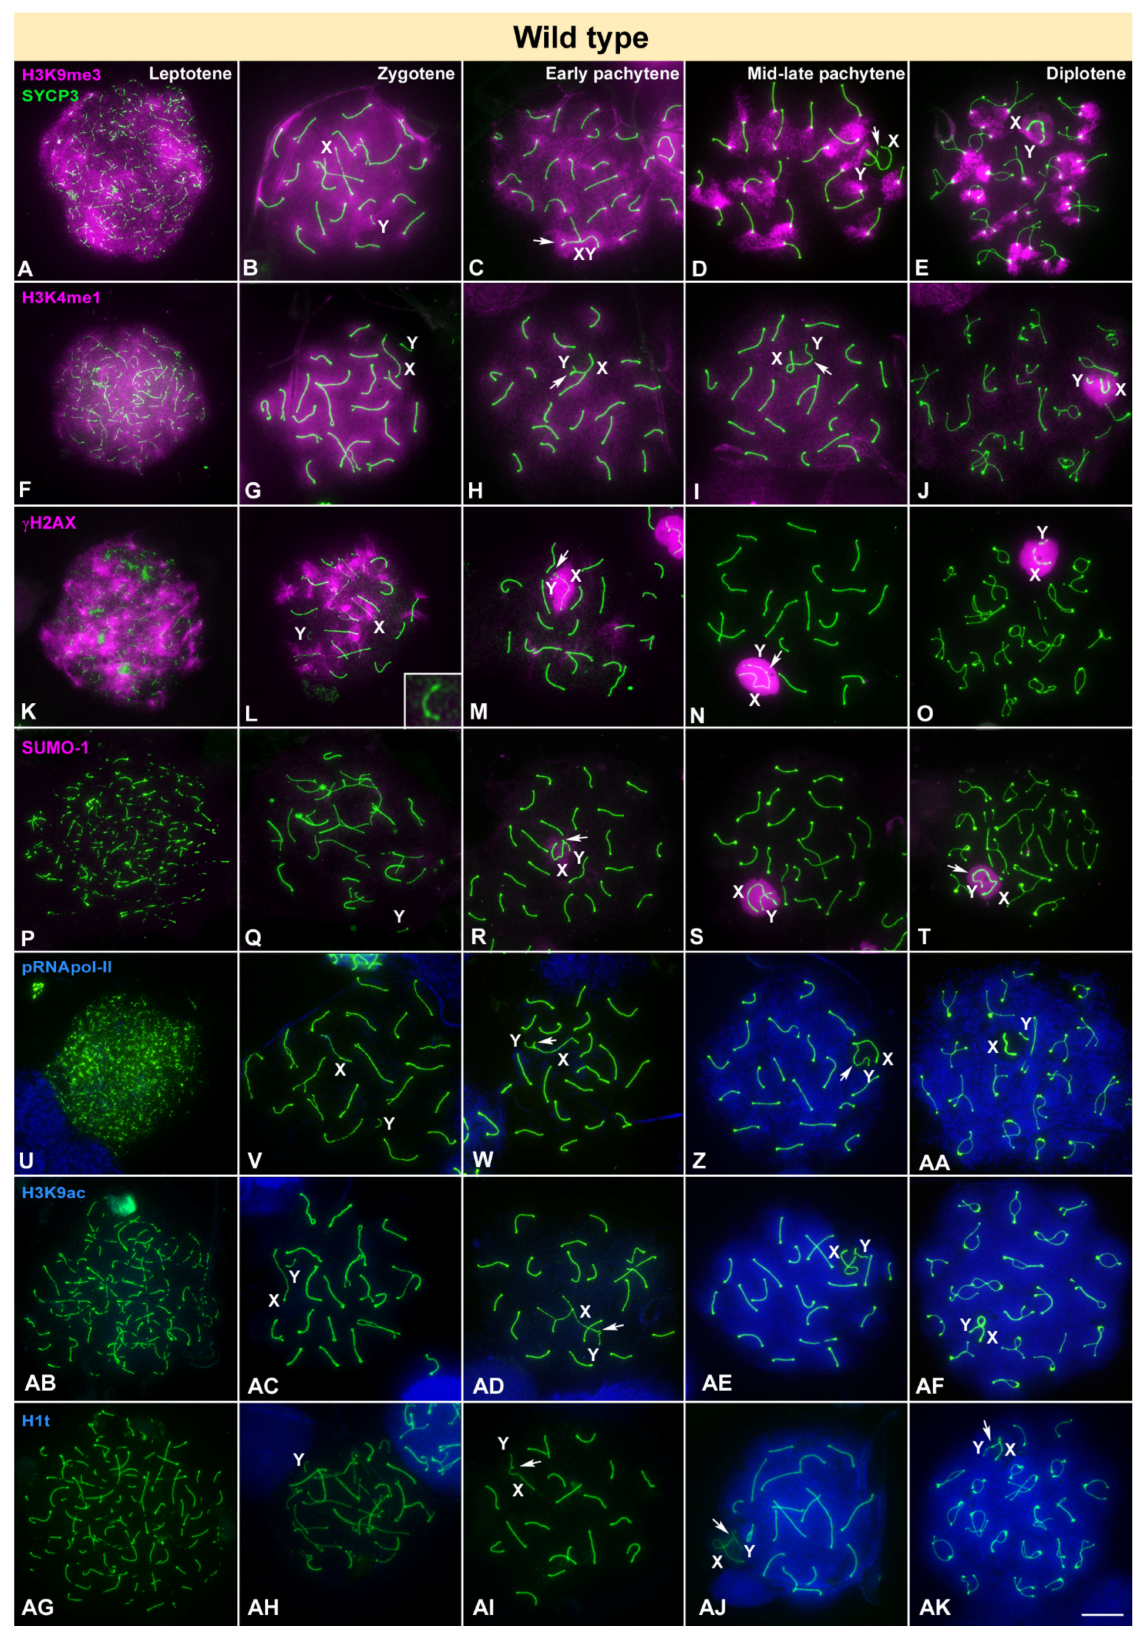
Figure 1. Immunolocalization of SYCP3 (green) and epigenetic markers of silencing (pink) or transcription activation (blue) in wild type mice. X, Y indicate sex chromosomes. Arrow indicates the synapsed region of sex chromosomes. ( A – E